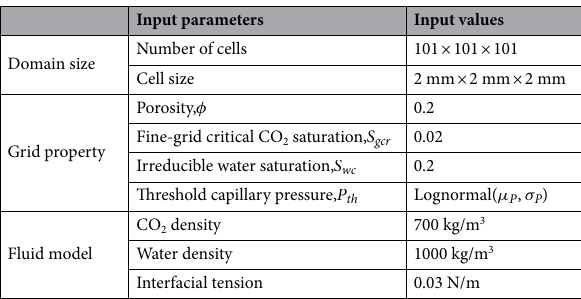
Table 1. Domain size, grid and fluid properties used in the MIP simulations.